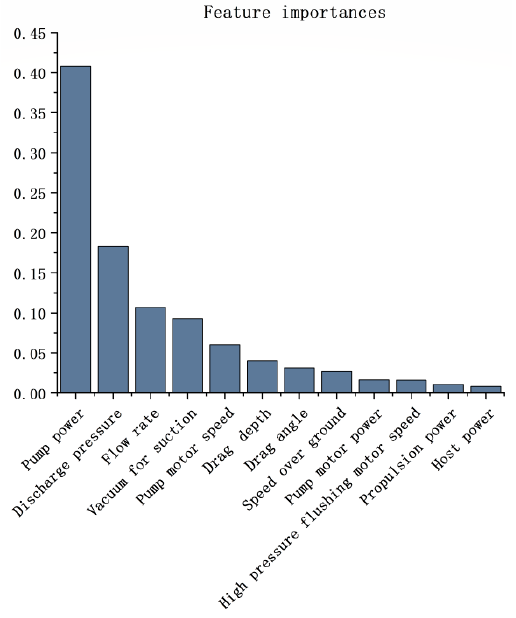
Figure 7. Analysis chart of feature contribution.